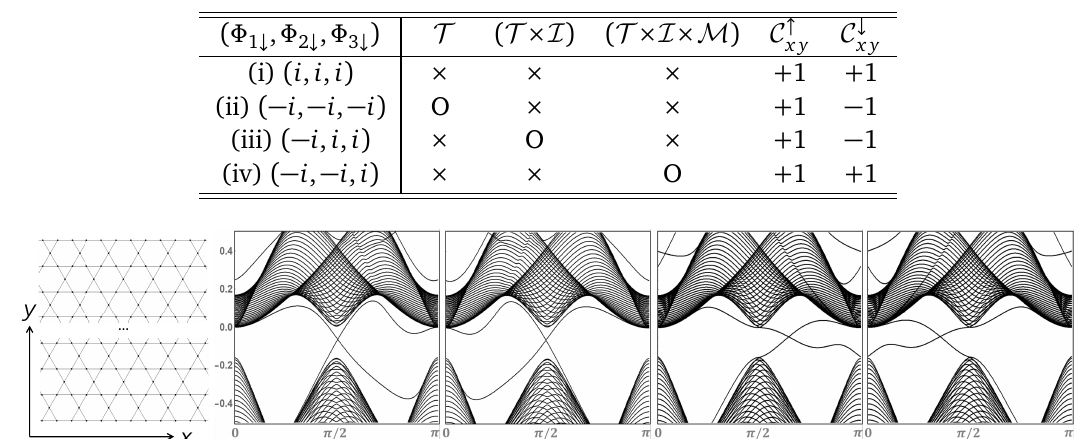
Table 1: Symmetry properties of 4 possible iCDW phases in Eq. (5) with the spin re- solved total Chern numbers. Only the down-spin order parameters are shown below while the reference up-spin components are given by ( Φ mark O or × indicates whether the iCDW phase preserves the corresponding symme- try or not.